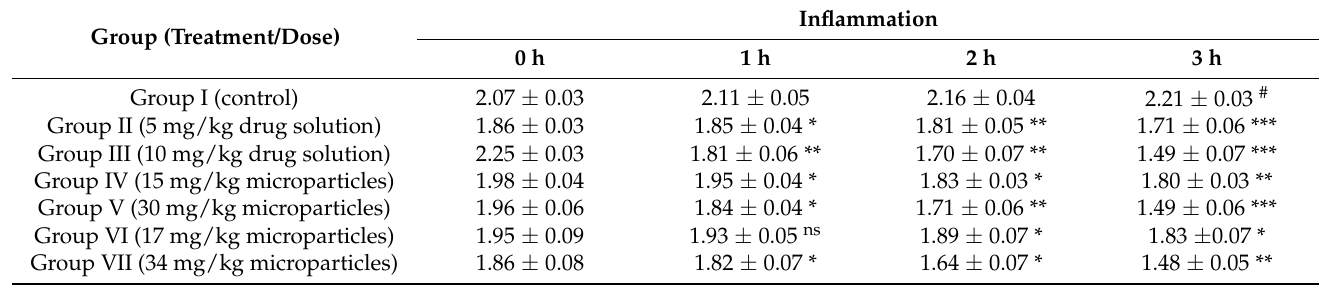
Table 3. Anti-inflammatory effects of test formulations in carrageenan-induced paw edema.